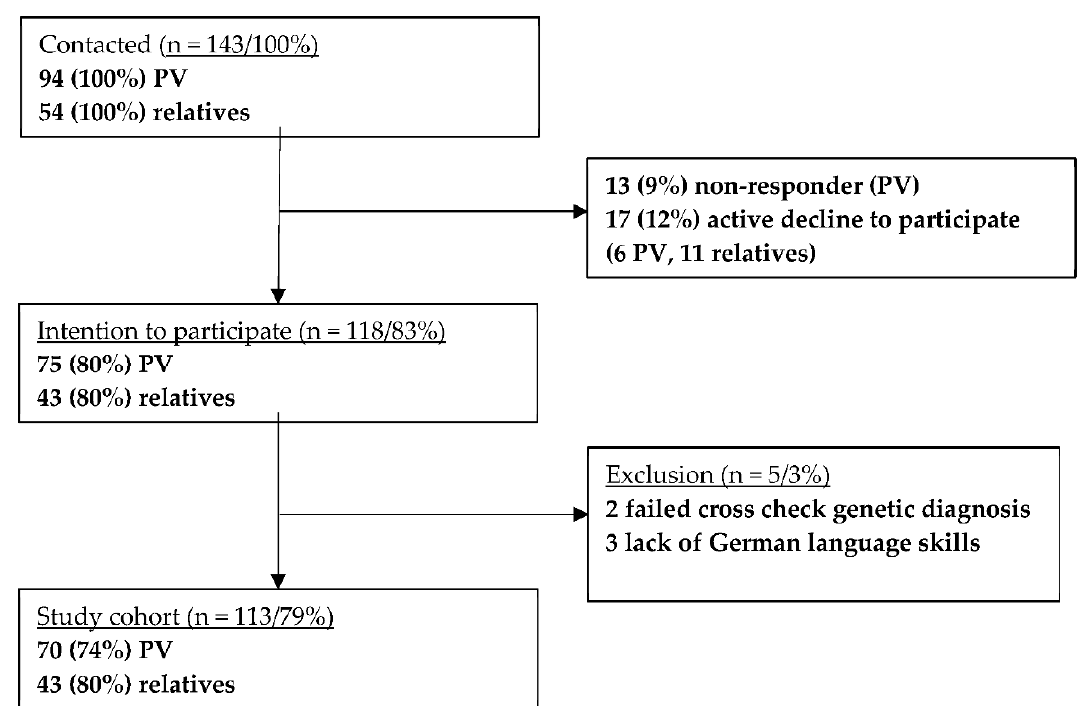
Figure 1. Flow chart of active recruitment. PV = pathogenic/likely pathogenic TP53 variant